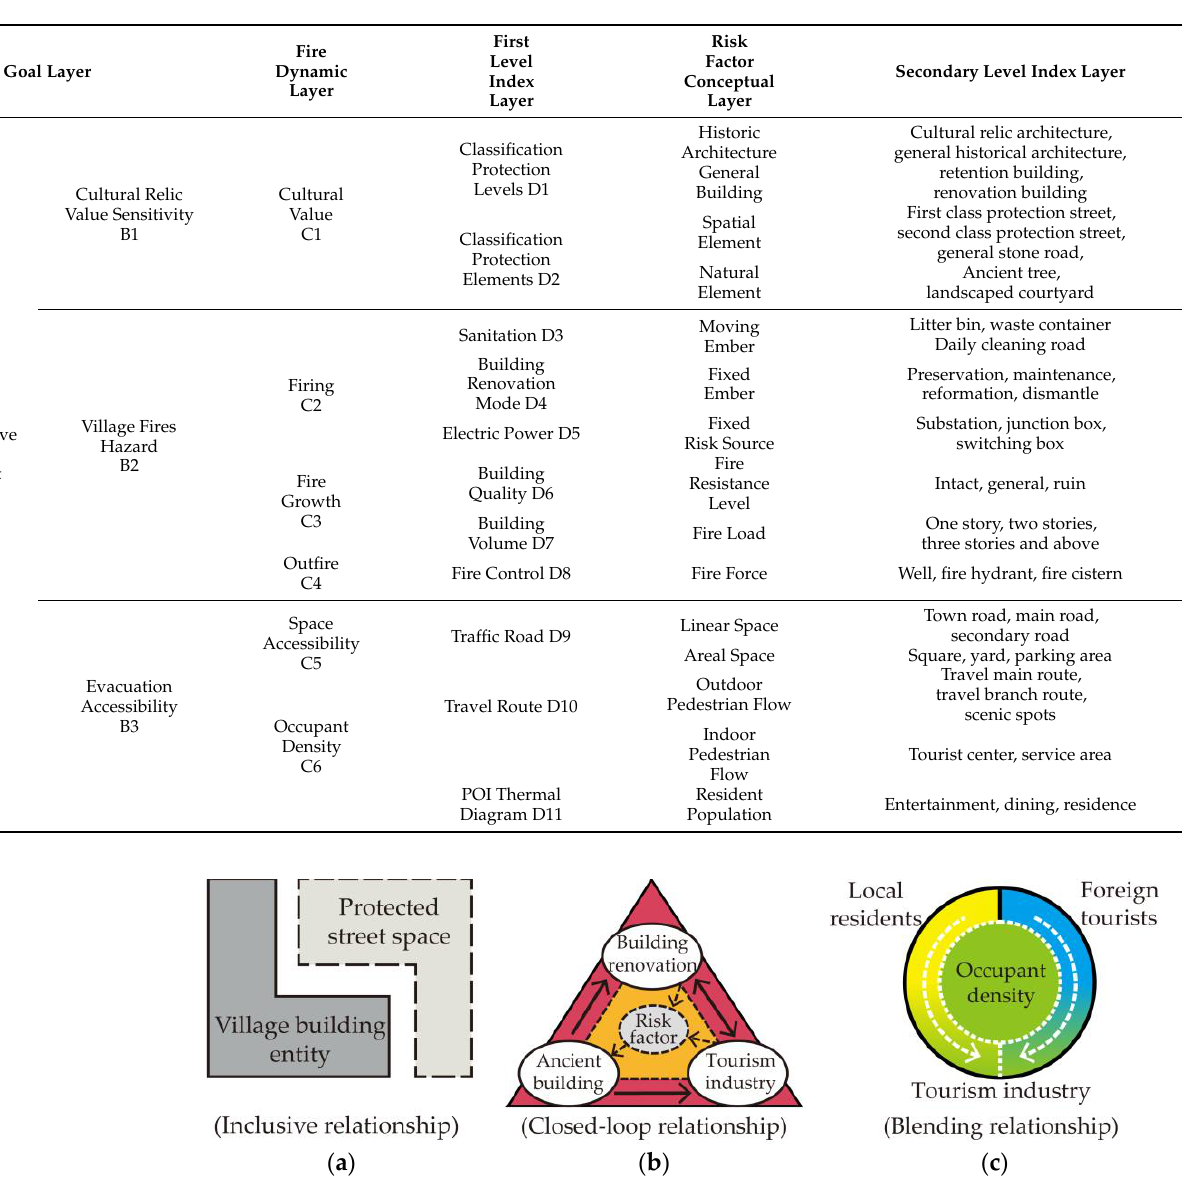
Figure 4. Index system factor logical relationship. Table 2. Fire risk assessment index.